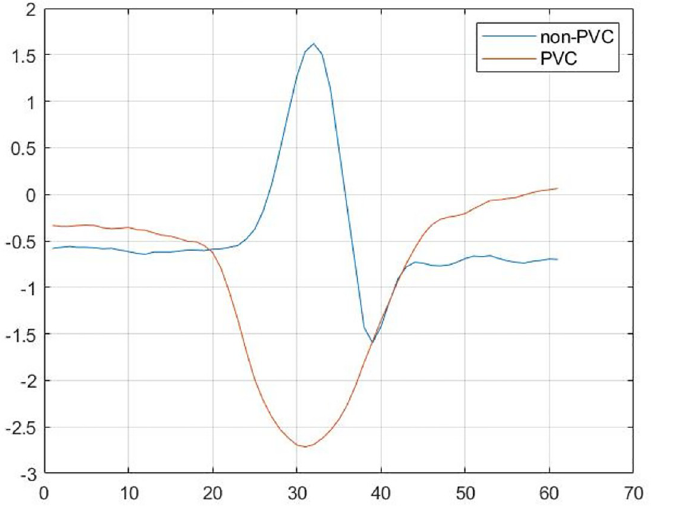
Fig 1. The difference between two signals: Normal and PVC